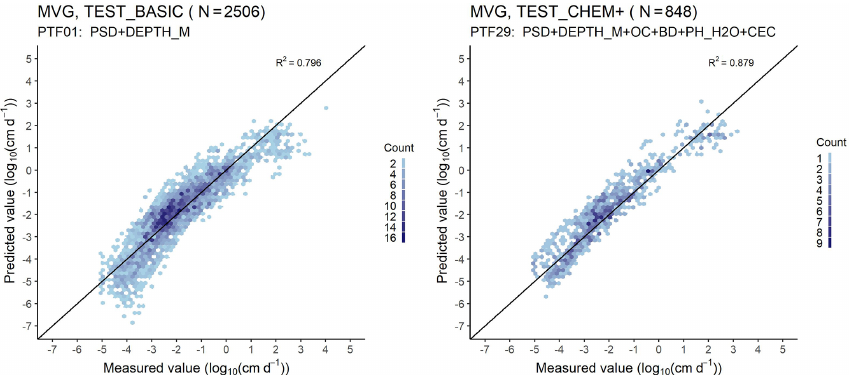
Figure 6. Scatter plot of the measured versus median predicted hydraulic conductivity values computed with the Mualem–van Genuchten (MVG) model (PTF01 vs. PTF27, i.e. the worst versus best performing PTF). PSD: particle size distribution (sand, 50–2000µm; silt, 2– 50µm; clay, < 2µm (mass%)); DEPTH_M: mean soil depth (cm); OC: organic carbon content (mass%); BD: bulk density (gcm − 3 ); CACO3: calcium carbonate content (mass%); PH_H2O: pH in water (–); Count: the number of cases in each